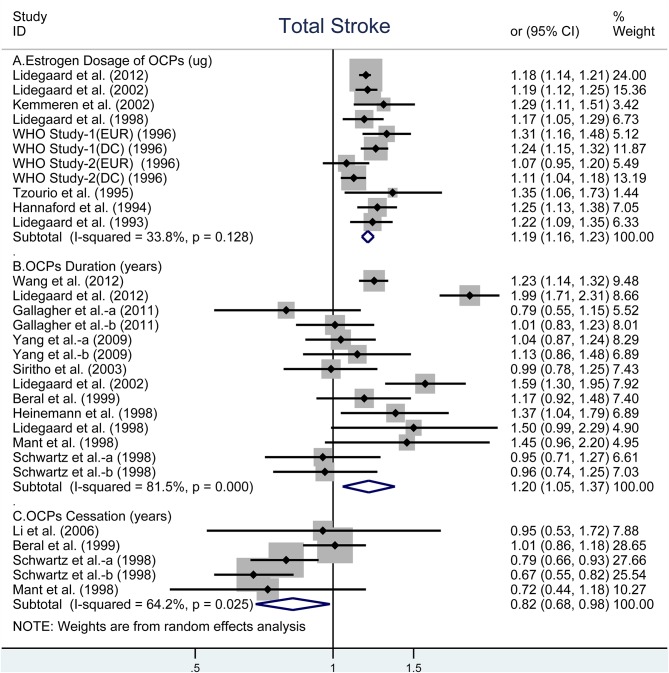
Forest plot of studies examining the association between OCP use [(A) estrogen dosage of OCPs, (B) OCPs duration, (C) OCPs cessation] and risk of total stroke.